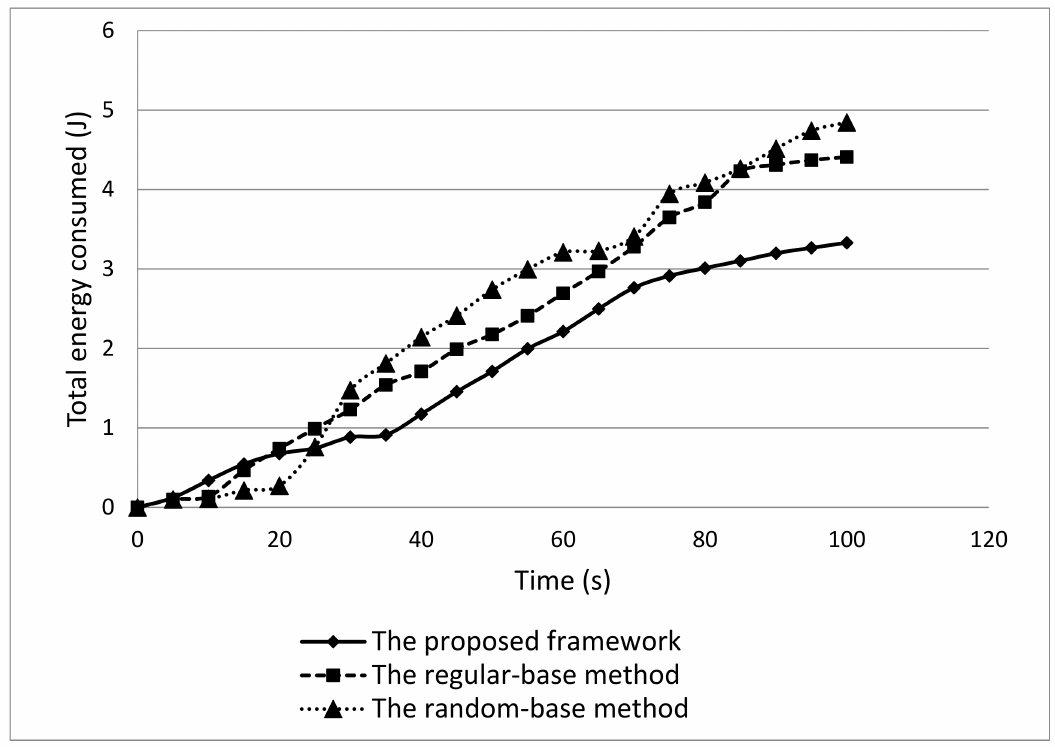
Figure 10. The total energy consumption of the three compared